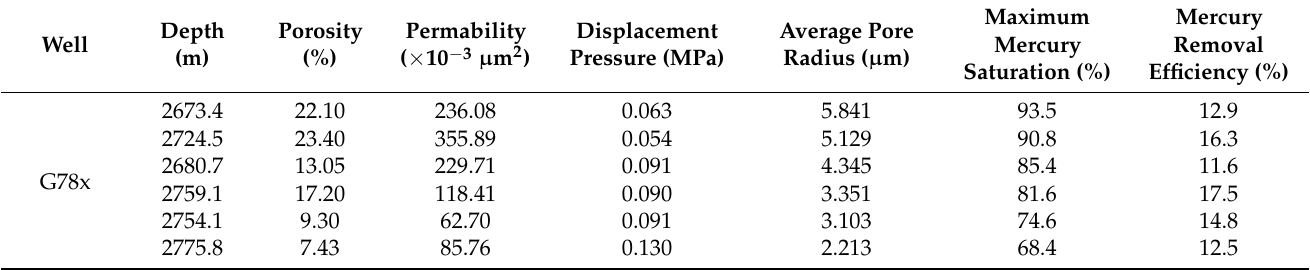
Table 2. Pore structure parameters of typical samples of Ek1 Formation in the Wang Guantun